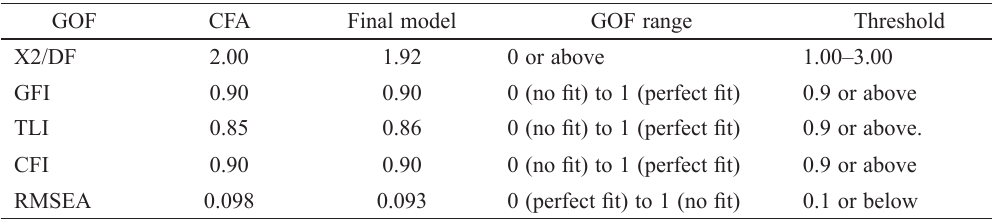
Table 4. Overall Goodness-of-Fit measures of CFA and the final model GOF